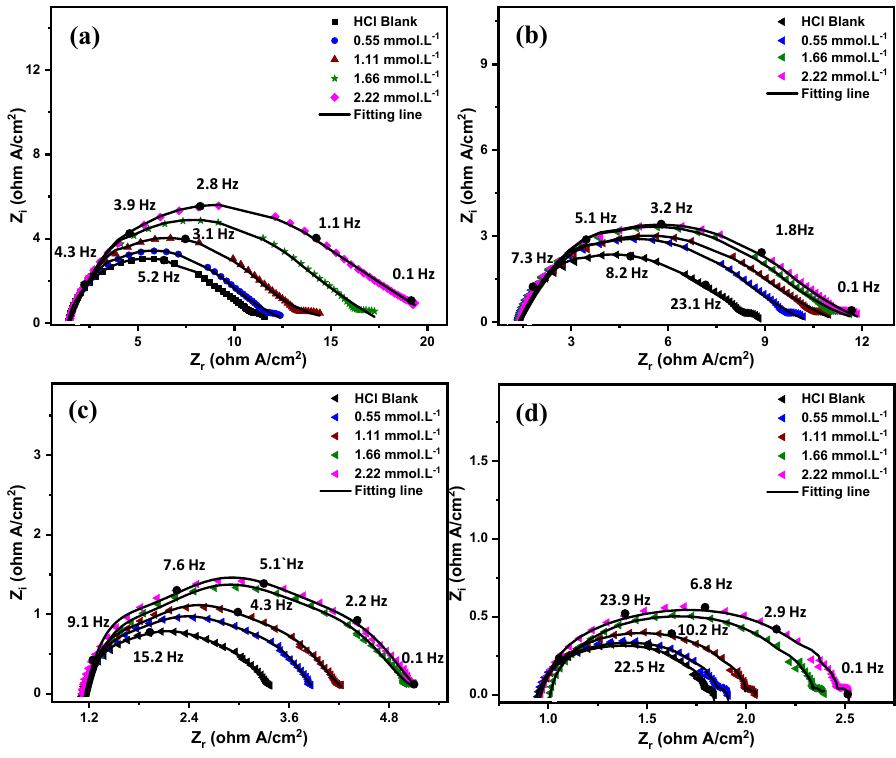
Figure 3. EIS Nyquist plots for C-steel in 5 M HCl in the presence and absence of 0.55, 1.11, 1.66 and 2.22 mmol·L −1 of Q-22 inhibitor at ( a ) 20 °C, ( b ) 30 °C, ( c ) 50 °C, and ( d ) 70 °C.